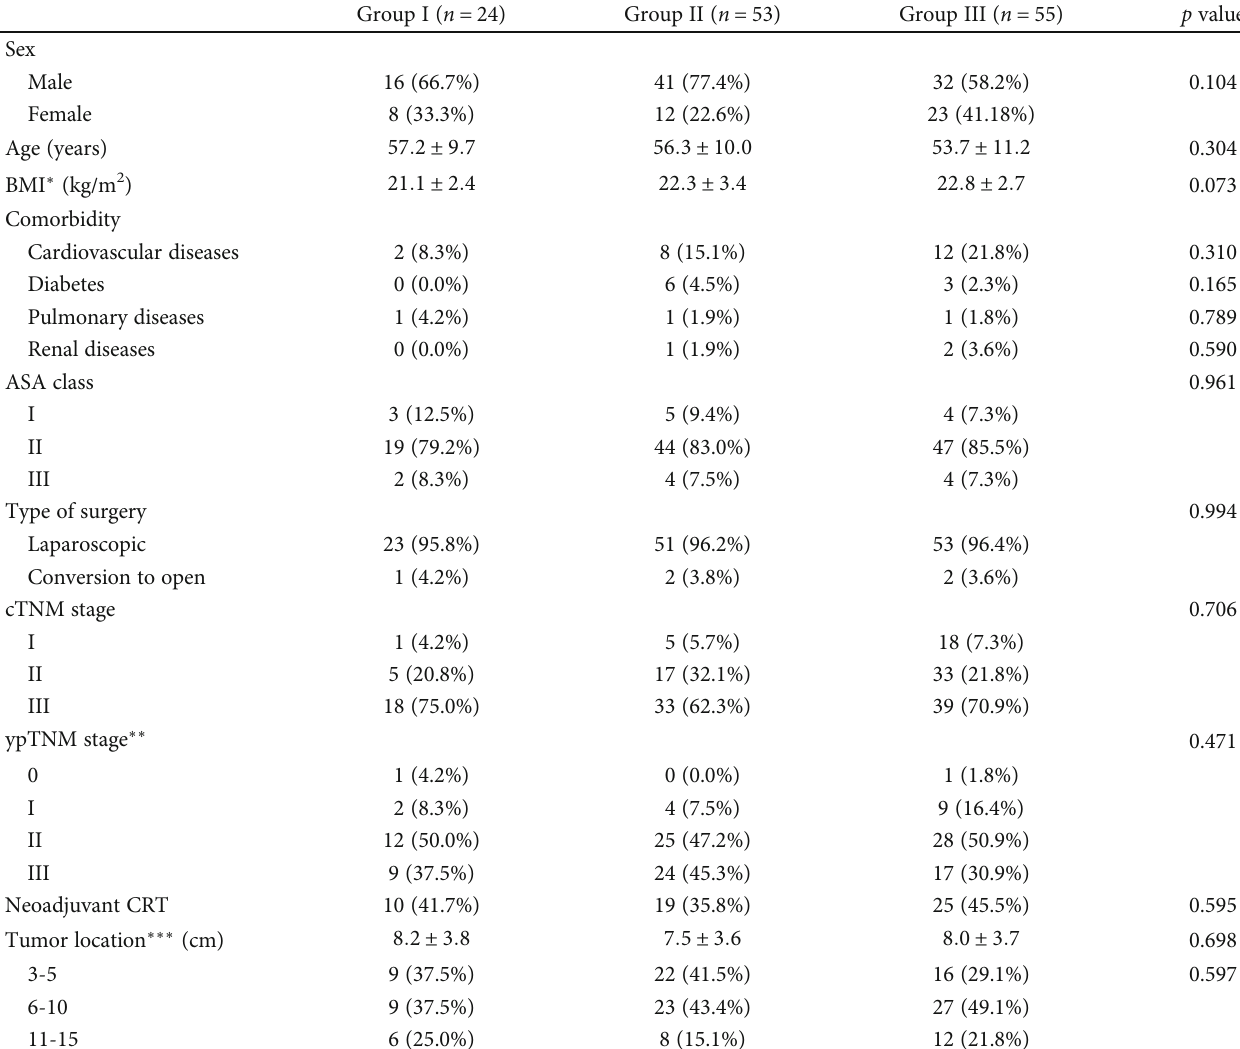
Table 1: Demographics and clinicopathologic characteristics of the study